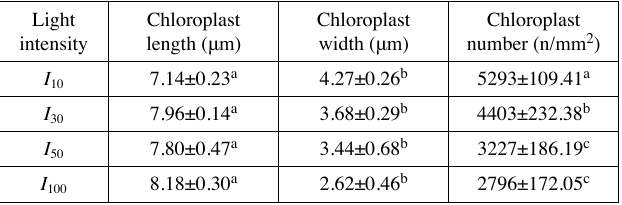
The values indicate the average ± SE. The same letters show there is no ob- vious difference in the four shade treatments (P<0.05)